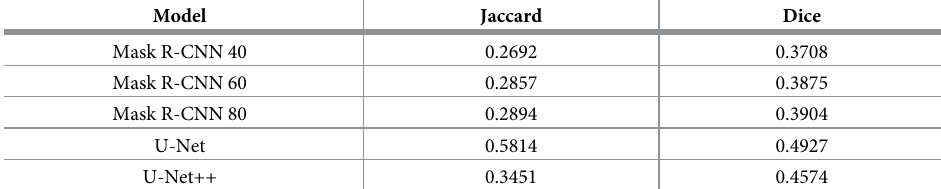
Table 6. Comparison between the segmentation models.